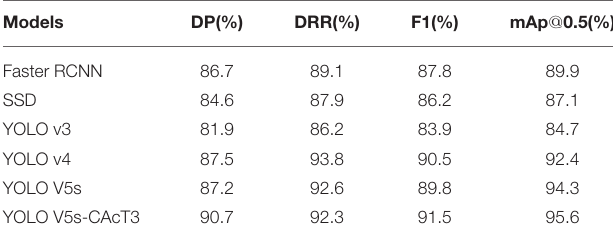
TABLE 6 | Test results of different models in the PFD